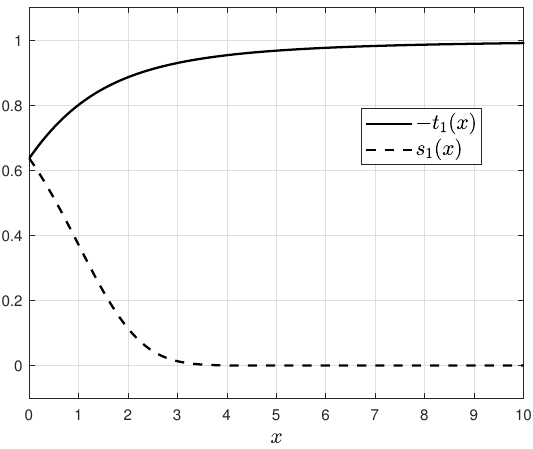
Figure 1. Verification for Lemma 2.